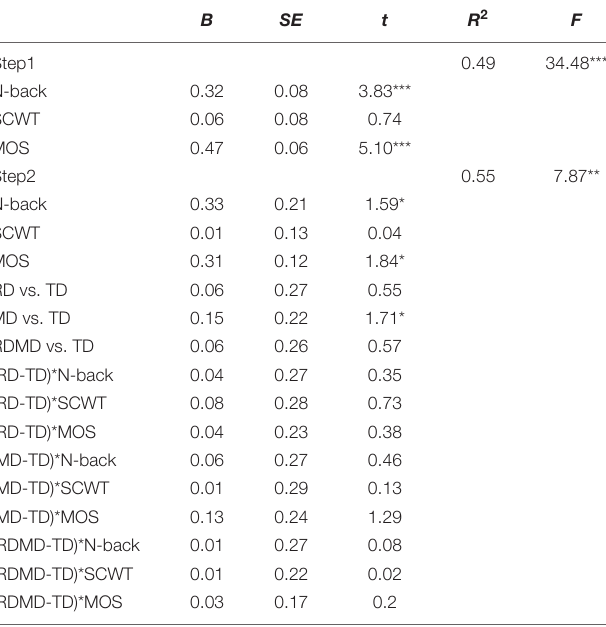
TABLE 3 | Correlation between the average RTs of PM and three components of executive function. PM 1-back SCWT